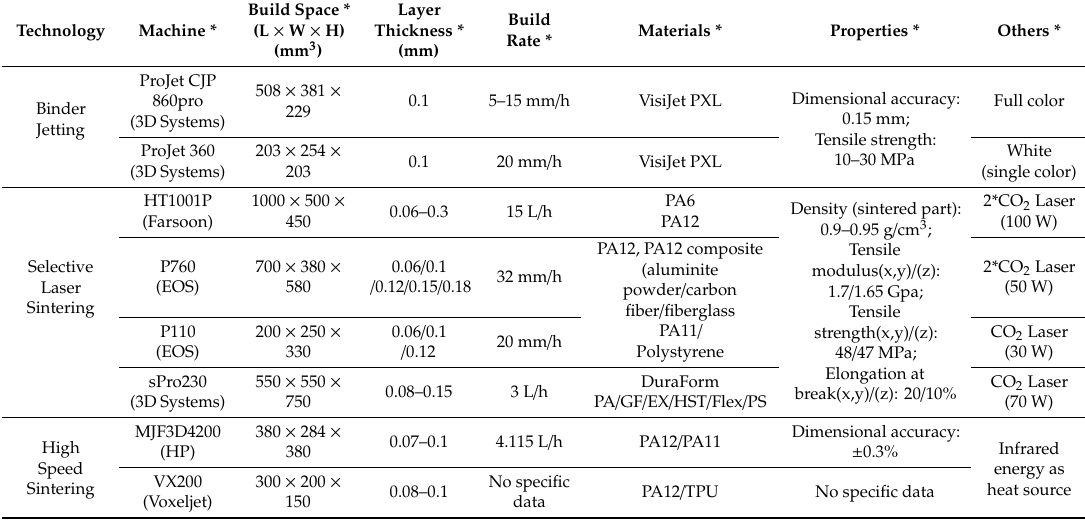
Table 1. Commercial devices of polymer powder based